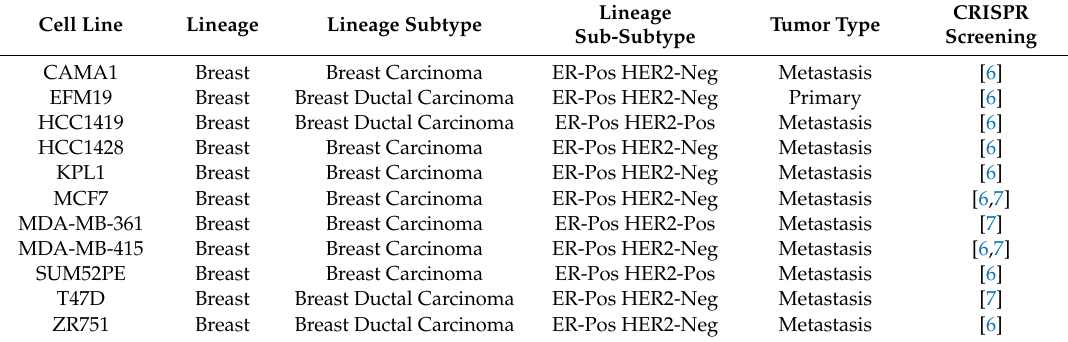
Table 1. List of the 11 BC ER α + cell lines screened in Meyers et al. [6] and / or Behan et al. [7].